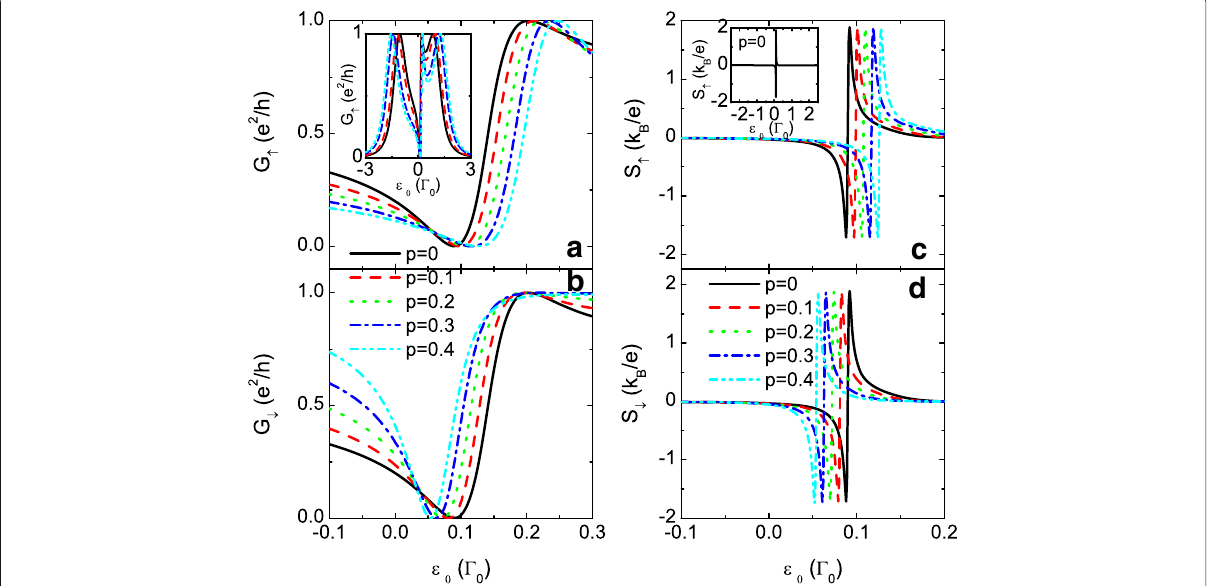
Fig. 5 Conductance and the thermopower for t 0 = 1. Spin-polarized conductance G σ in a and b , and the thermopower S σ in c and d as functions of the dot level ε 0 for t 0 = 1, t c = 0.3 and different values of the spin polarization of the interdot couplings p . The insets in a and c are the conductance and the thermopower in a large dot level regime respectively. The other parameters are as in Fig.